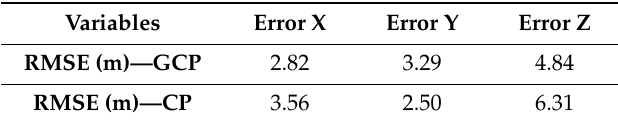
Table 1. Root mean square error (RMSE) values referring to the 50 ground control point (GCP) and 25 check point (CP) dataset.